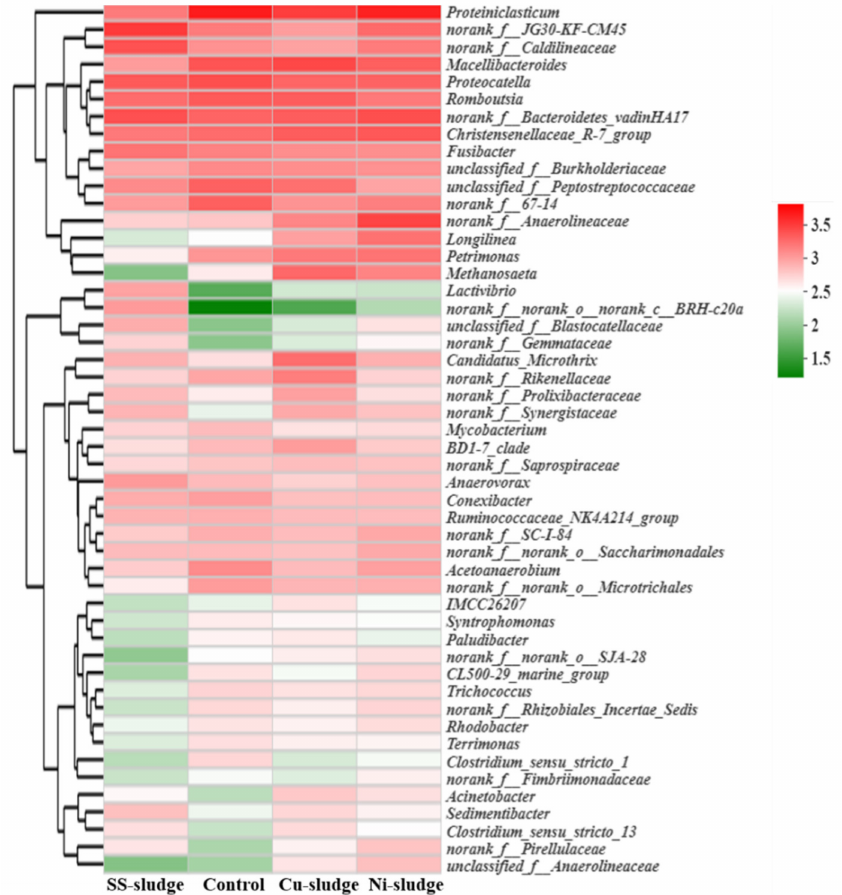
Figure 6. Heatmap of sludge community structure at genus